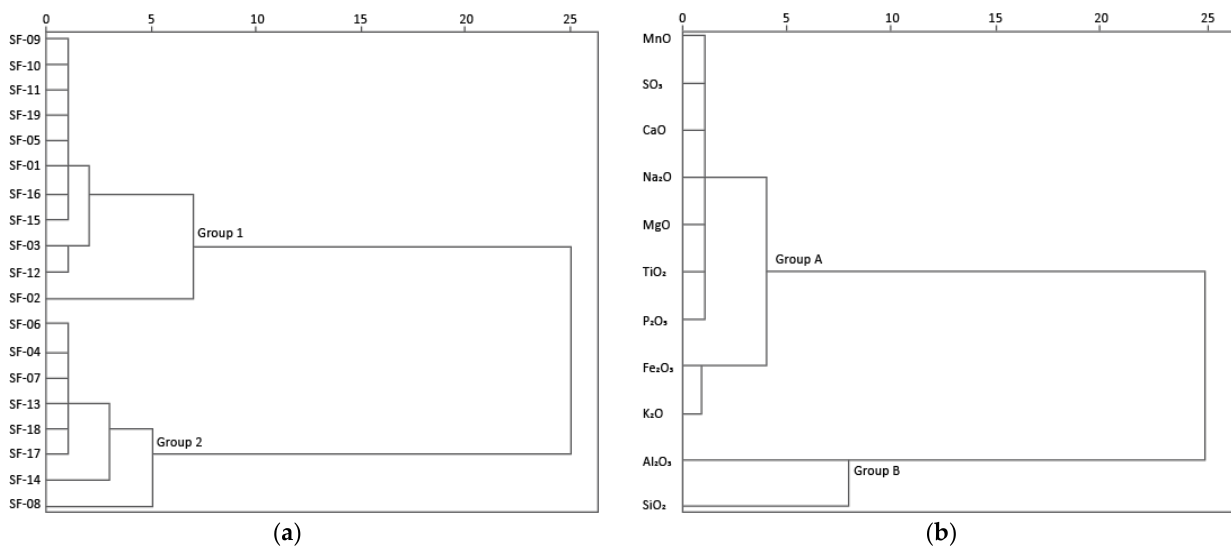
Figure 4. Cluster analysis of mortars and bricks samples major element concentrations: ( a ) samples, and ( b ) variables.